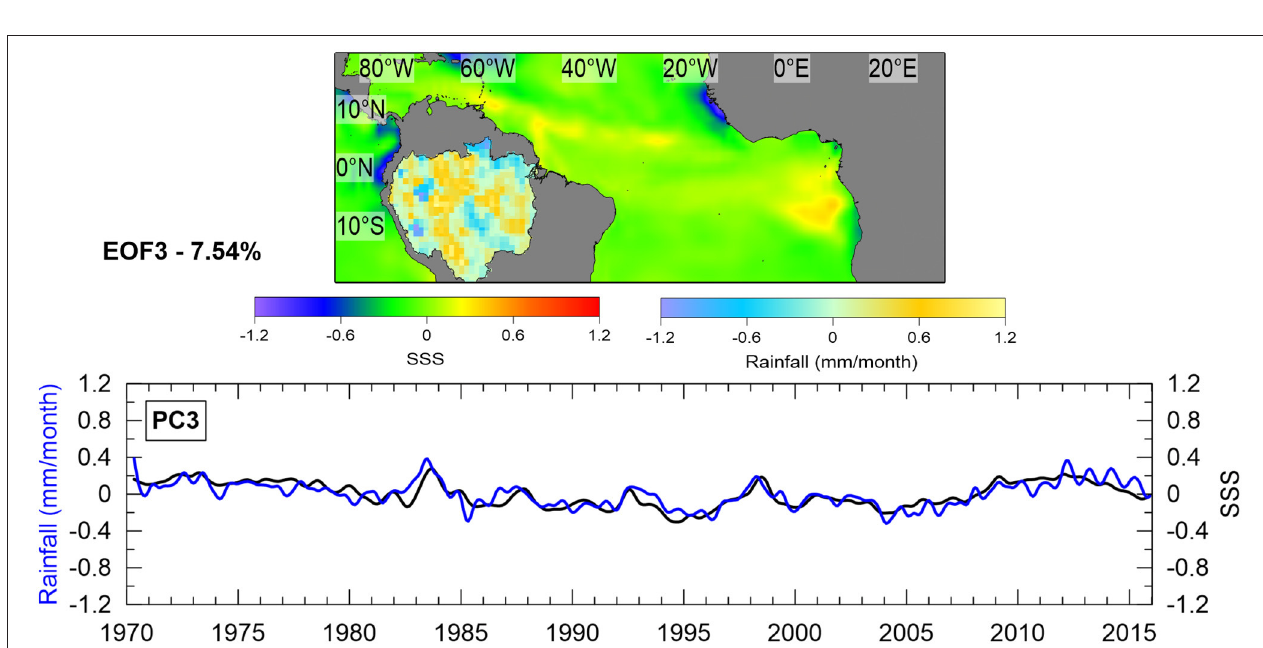
FIGURE 6 | Third EOF of 3 month-lagged covariance matrix between rainfall (normalized scale by 10 3 ) and SSS (normalized scale by 10), the Squared Covariance Fraction (SCF) in percentage, and the third Principal Component (PC3).